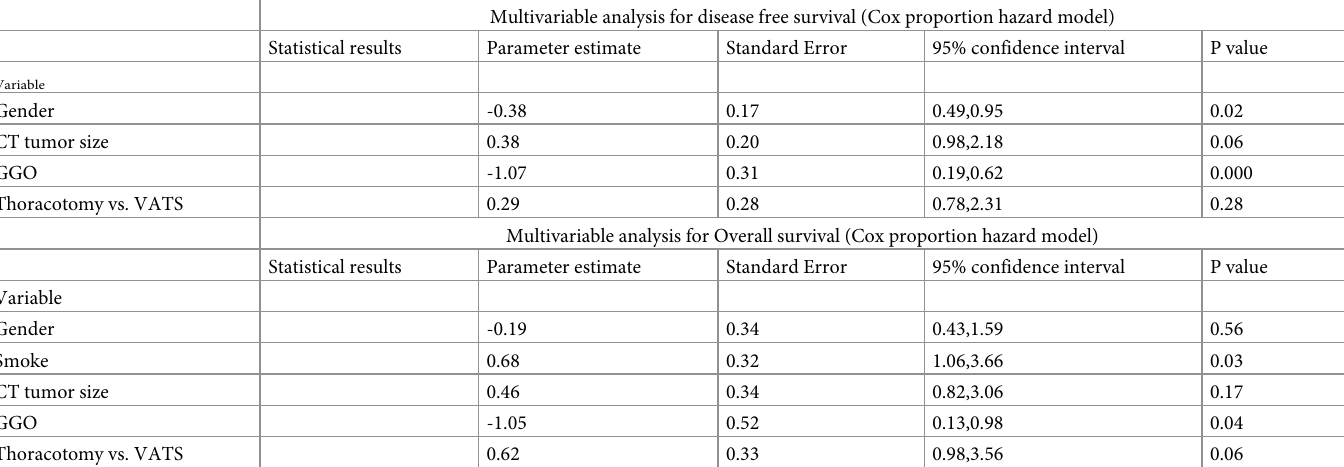
Table 4. Multivariable analysis for disease free and overall survival (cox proportion hazard